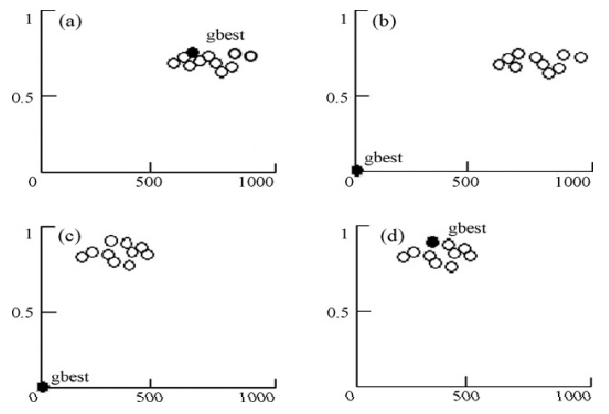
Figure 1(a) Trapping of gbest in local, (b) Resetting of gbest to zero, (c) Resting gbest and particle movement, (d) Convergence of particles towards